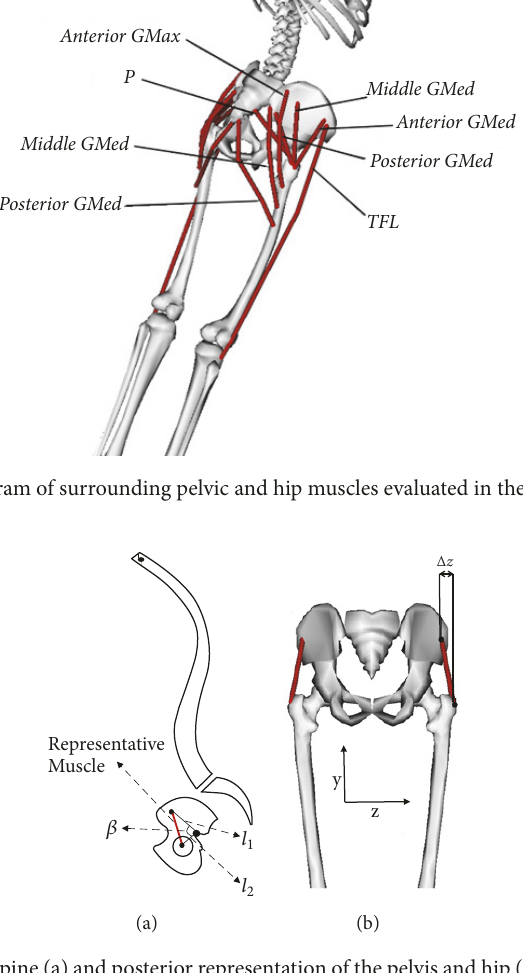
Figure 5: Sagittal Representation of the spine (a) and posterior representation of the pelvis and hip (b) showing lengths l 1, l 2, Δ z, and angle 𝛽 used in the predictive equation for muscle length. These parameters are different for each muscle segment. The red line represents a muscle segment